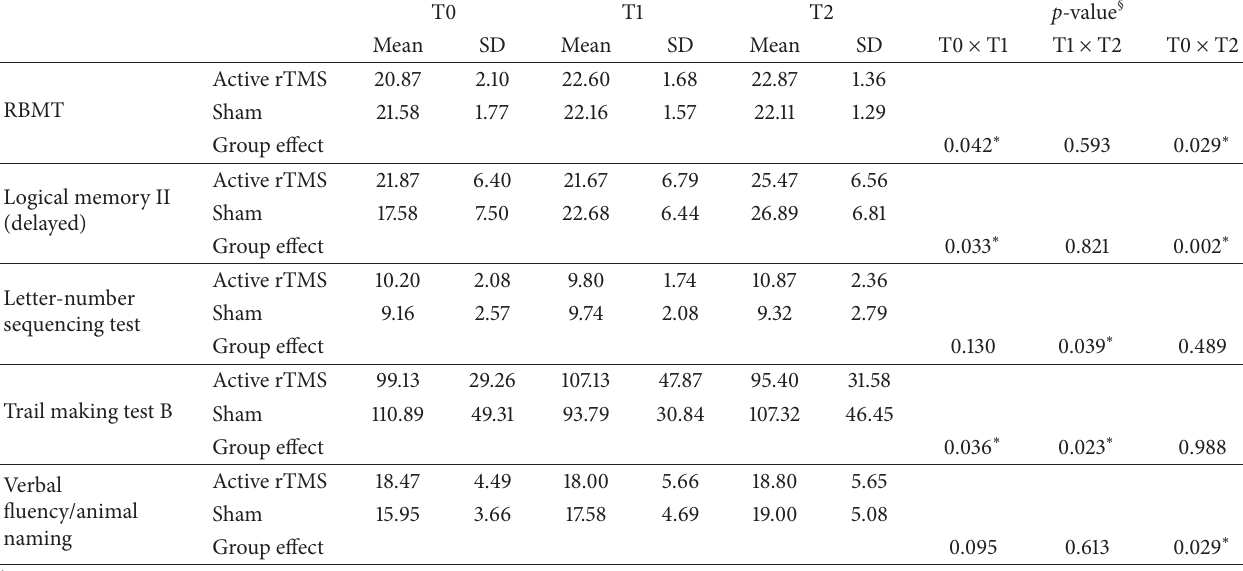
Table 7: Comparison of the statistically significant neuropsychological outcomes.